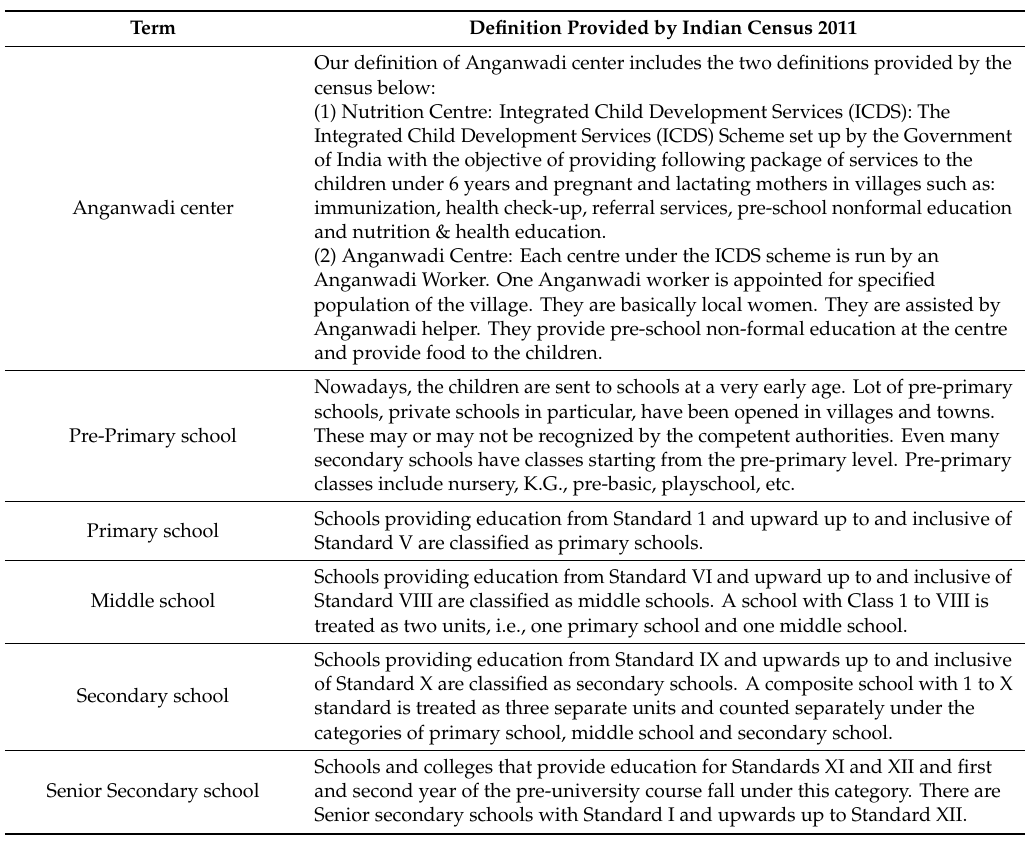
Table 1. Definitions provided by the 2011 Indian Census for the education infrastructures that we considered in our